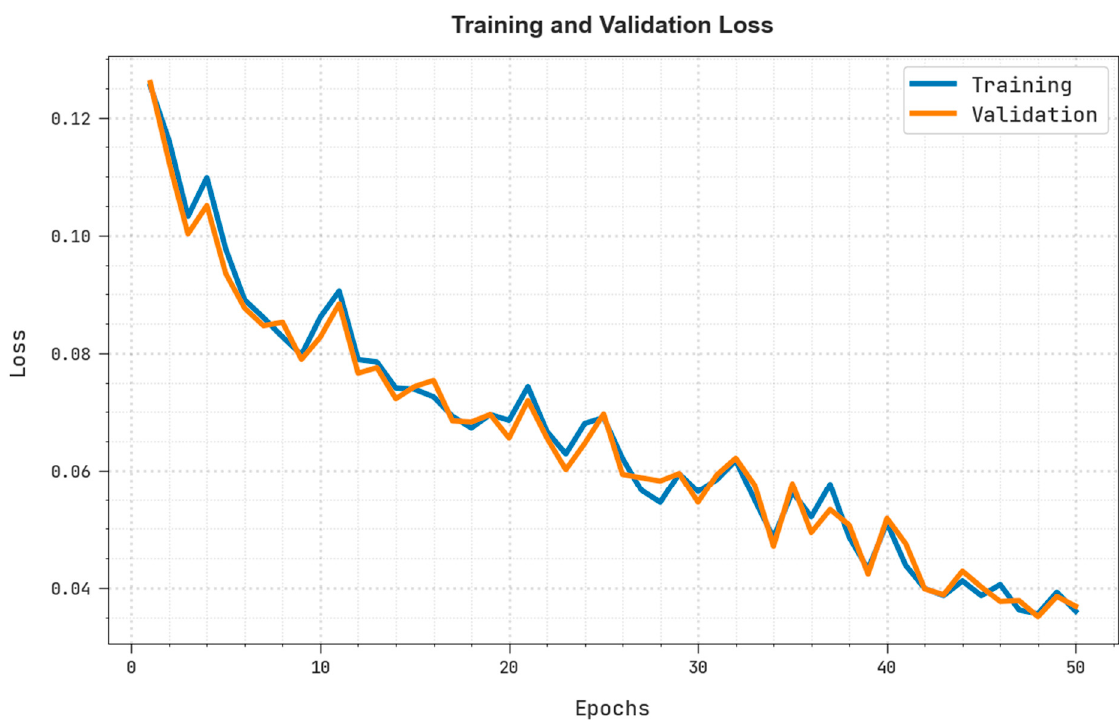
Figure 8. TRL and VLL analysis for BND-BMOML algorithm.